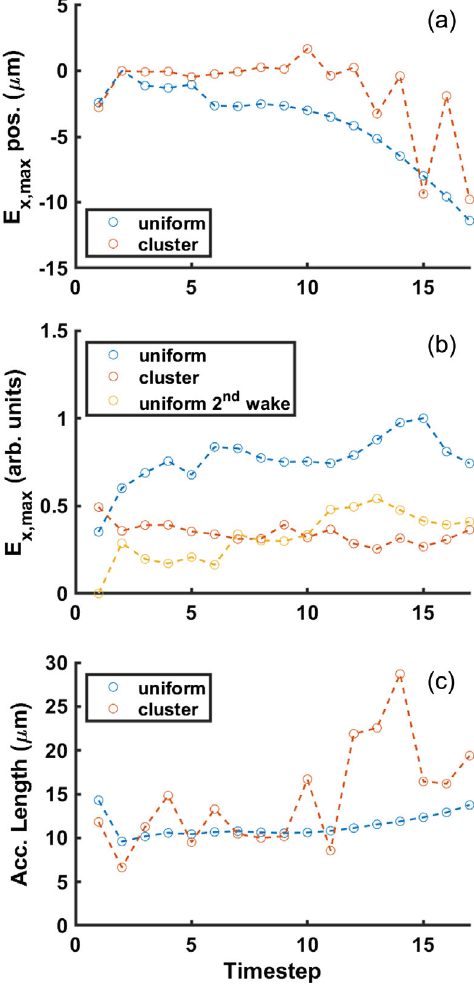
FIG. 2. Comparison of the wakefield evolution in a uniform and a cluster plasma (simulations D and E — see table I). Panel (a) shows the position of the maximum accelerating longitudinal field plotted against time. The zero (reference) value on the y-axis was chosen to be at time step 2 where the maximum plasma density has been reached after the density ramp. Panel (b) shows the normalized peak accelerating electric field strength for cluster and uniform cases as well as the value for the second wake in the uniform case. Panel (c) shows the maximum acceleration length, defined as the distance between troughs where the electric field in the first bubble is negative (and thus accelerating). Here, one time step corresponds to 0.25 ps in simulation D and to 0.26 ps in the other simulations. All values are taken from a line-out on the laser propagation axis.